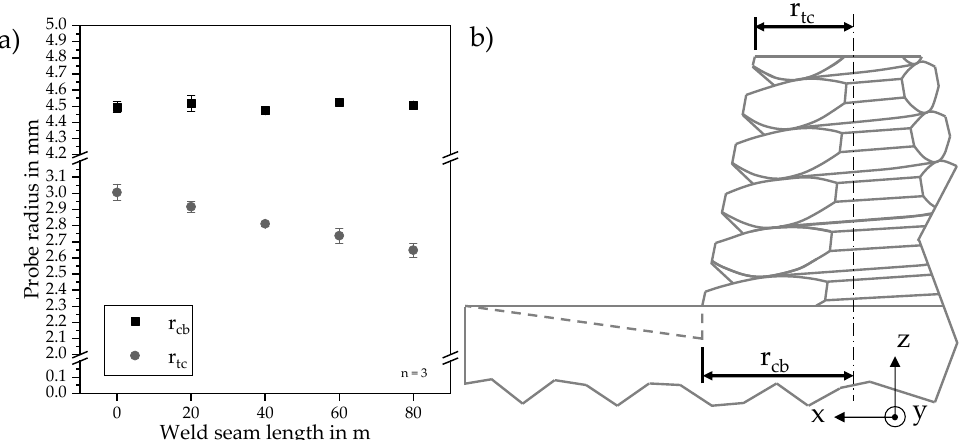
Figure 10. Wear behavior of the probe radii as a function of the weld seam length in ( a ) measured with the stripe light projection and ( b ) at the measuring points.